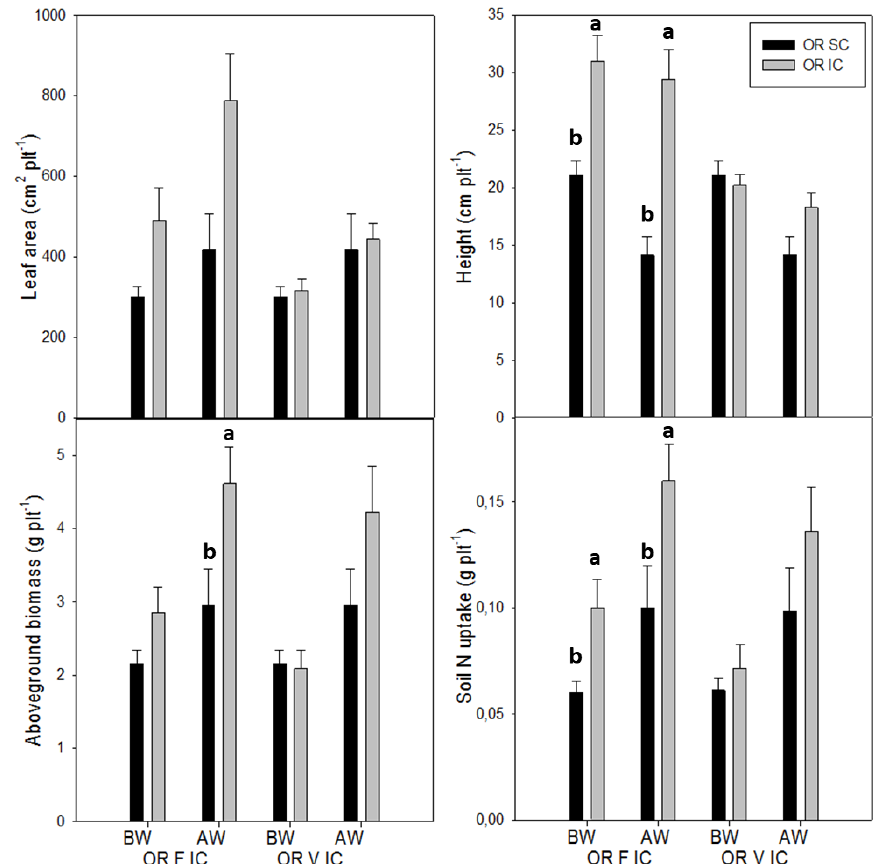
Figure 2. Effects of legume species on intercropped oilseed rape (OR) with faba bean (OR F IC) or common vetch (OR V IC) before winter (BW) in December and after winter (AW) in February compared to oilseed rape sole crop (OR SC). Values are mean ( n = 8) ± standard error for the two experimental years (2013/14 and 2015/16), except for leaf area after winter ( n = 4), which was measured